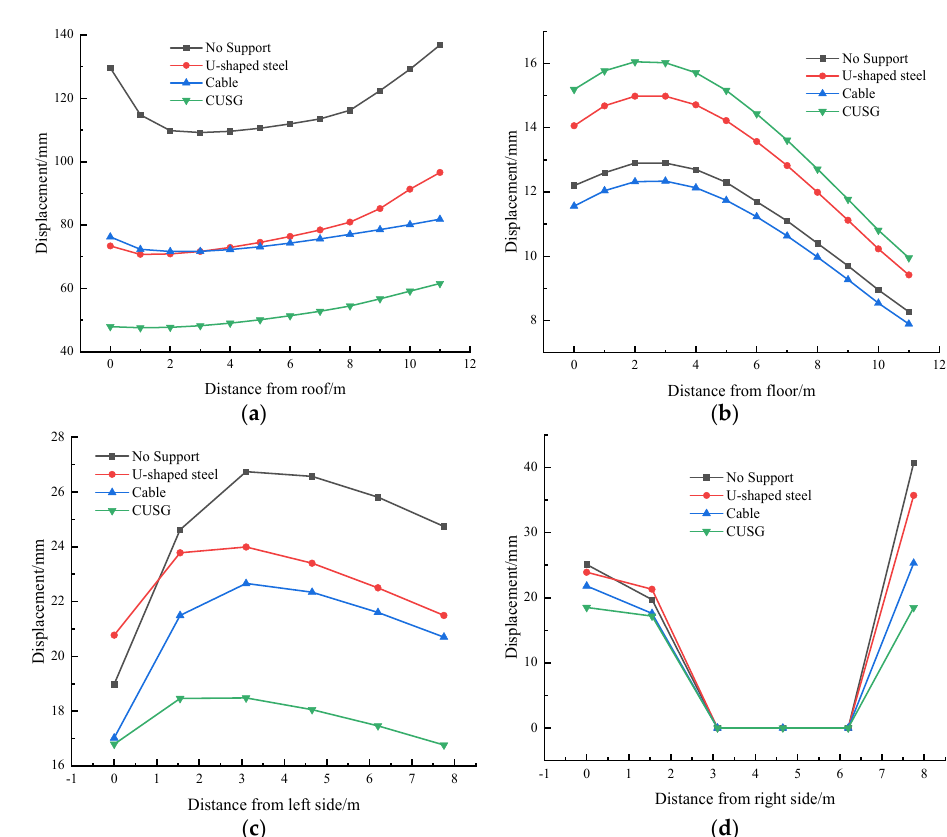
Figure 7. Displacement evolution. ( a ) Distance from roof, ( b ) distance from floor, ( c ) distance from left side, and ( d ) distance from right side.